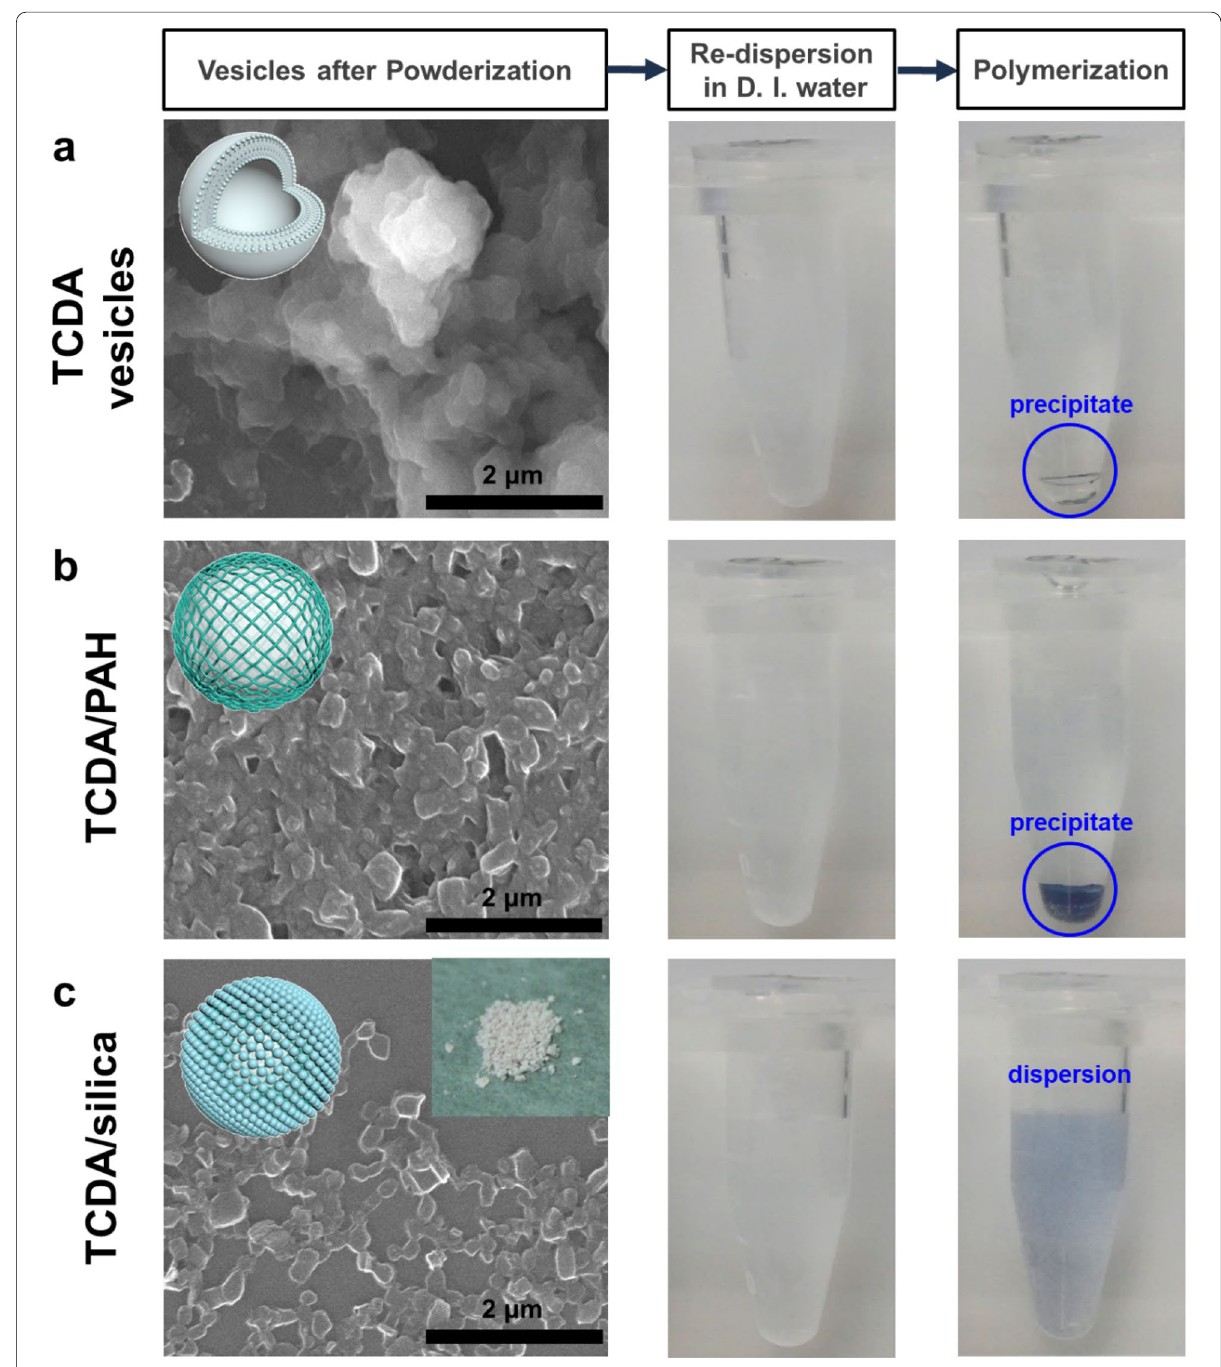
Fig. 3 Redispersibility of TCDA vesicles with layer encapsulation. SEM images of monomeric a TCDA vesicles, b TCDA/PAH, and c TCDA/silica after powderization (Inset image of c : TCDA/silica powder), and photo images of the sonicated monomeric powders into deionized water and its polymeric